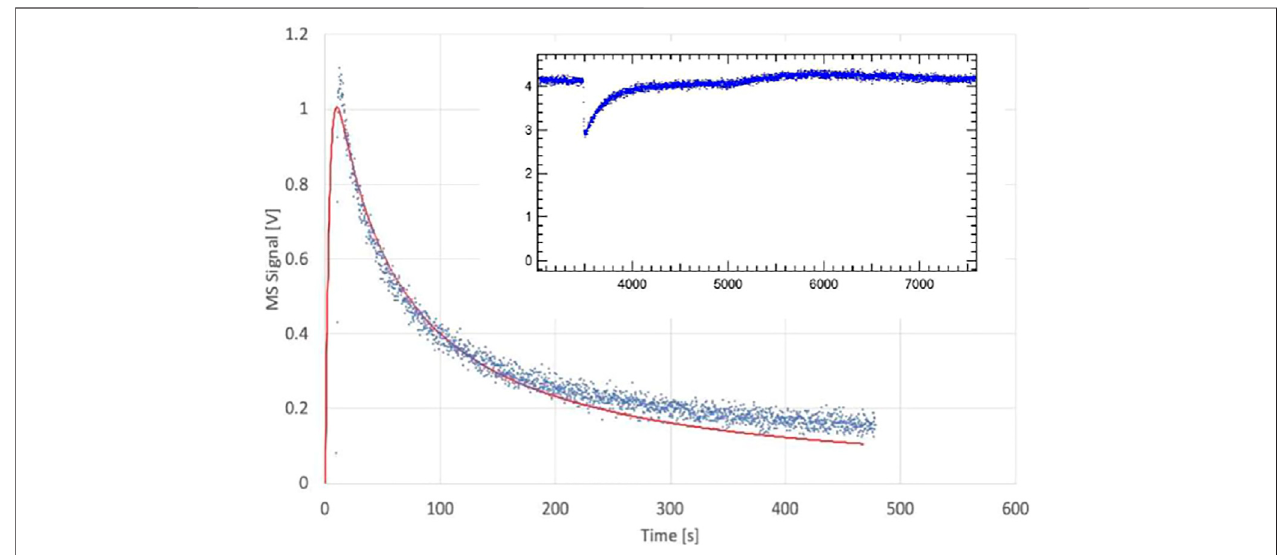
FIGURE 8 | Desorption of H 2 O monitored at m/e = 18 amu from 4.5 mg sample of previously saturated PAC (S131), uptake on clean PAC in 1 mm Ø ori fi ce KFR shownintheinsert(ordinateinVLIA),SCclosedat6,300pts.;F i =4.12×10 15 molecules − 1 ,k 0 =0.12s − 1 ;desorptionparametersarek d =4.0×10 − 4 s − 1 ,k e =0.277 s − 1 , k a = 15 s − 1 . Insert shows corresponding H 2 O uptake phase (see